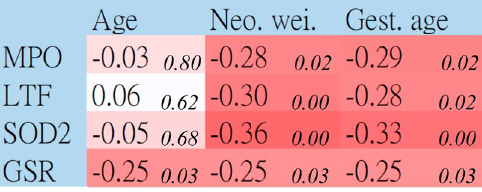
Figure 4. Correlations and p values between protein concentrations and clinical manifestations. We examined whether the concentrations of four protein biomarkers were correlated with the clinical manifestations by conducting correlation analysis on all 72 participants. Age denoted maternal age at delivery. In each column, the left digit and right digit (in italic style) denote the correlation coefficient and p value, respectively. The deeper red pixels denote higher correlation